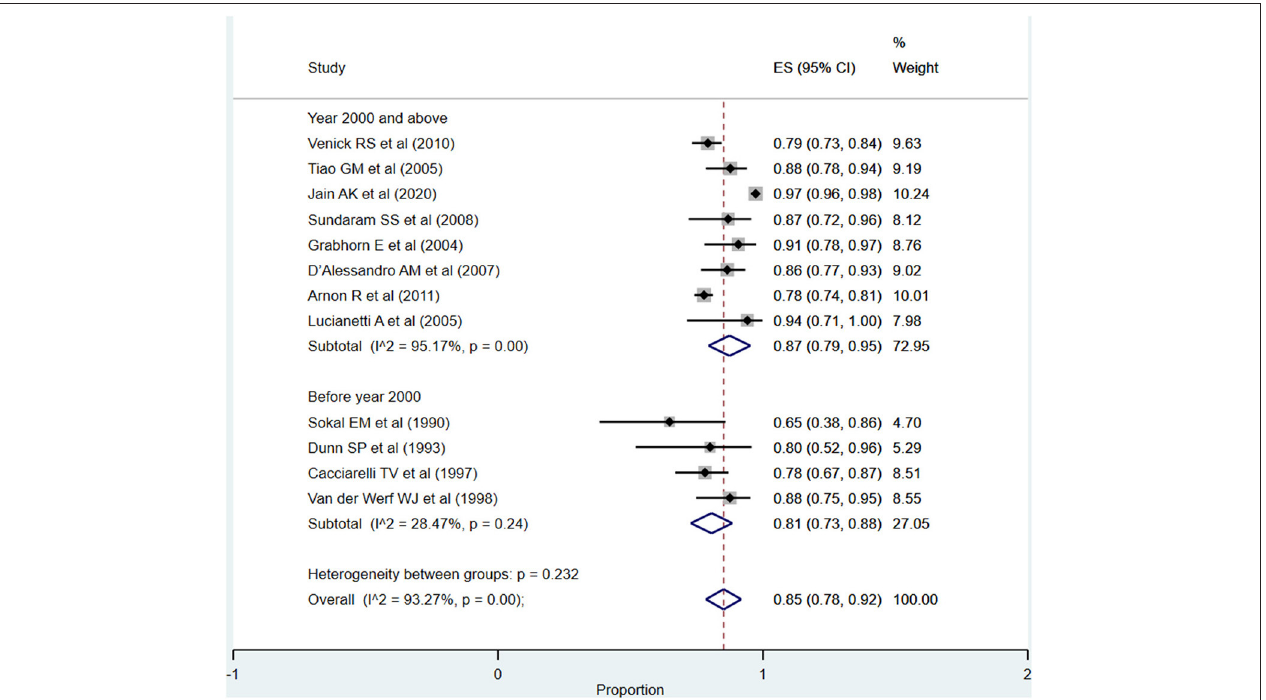
FIGURE 2 | Pooled patient survival rate among infants at or within 1 year post-liver transplantation.